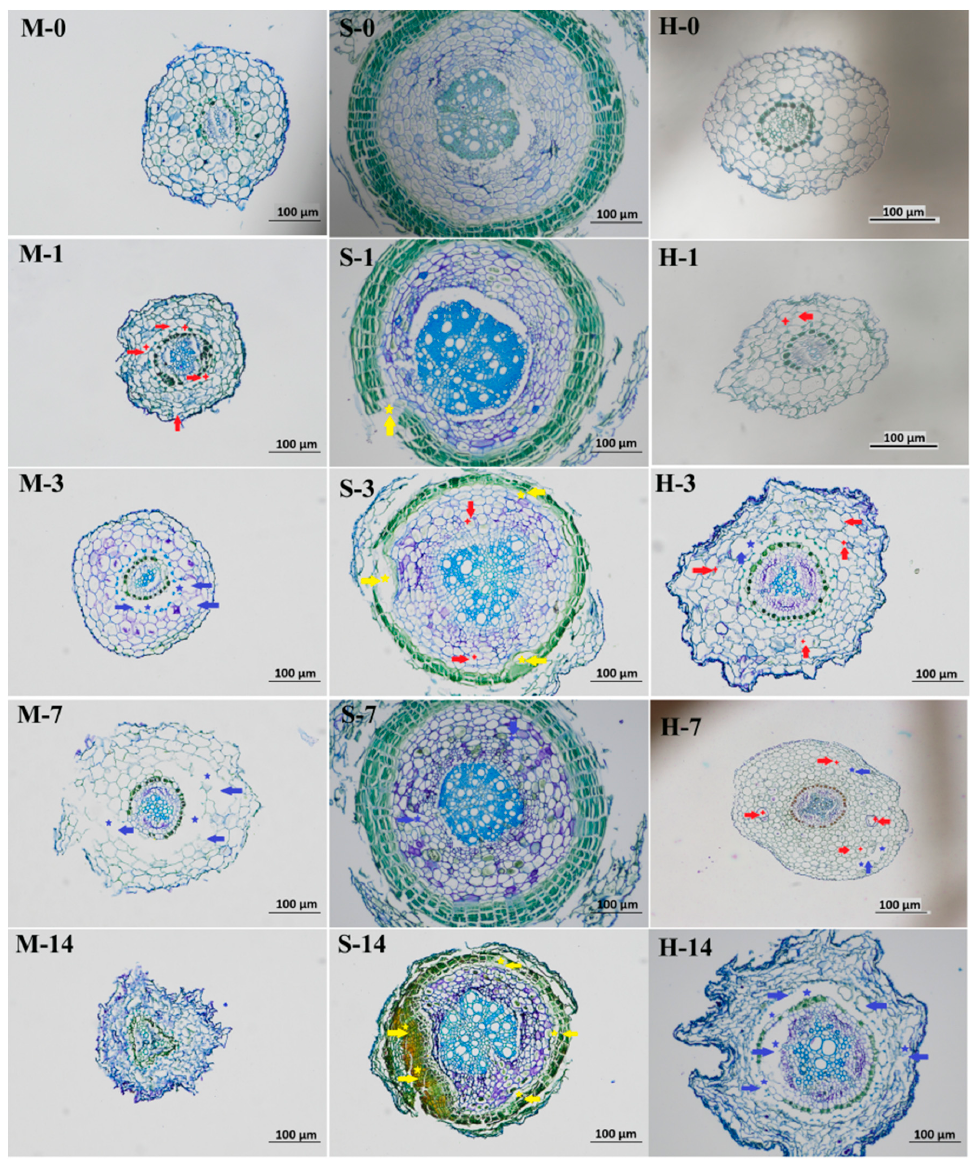
Figure 8. Comparison of anatomical structure changes of fine roots of different peach rootstocks under different time duration of waterlogging (yellow asterisk/arrow: lenticular structure; blue asterisk/arrow: air cavities; red asterisk/arrow: adjacent cells fused with each other; Bar = 200 μ m). Abbreviations: M: Prunus persica, ‘Maotao’; S: Prunus davidiana, ‘Shantao’; H: ‘Hossu’. Fine root samples were collected on non-stressed condition (M-0, S-0, H-0), 1st day (M-1, S-1, H-1), 3rd